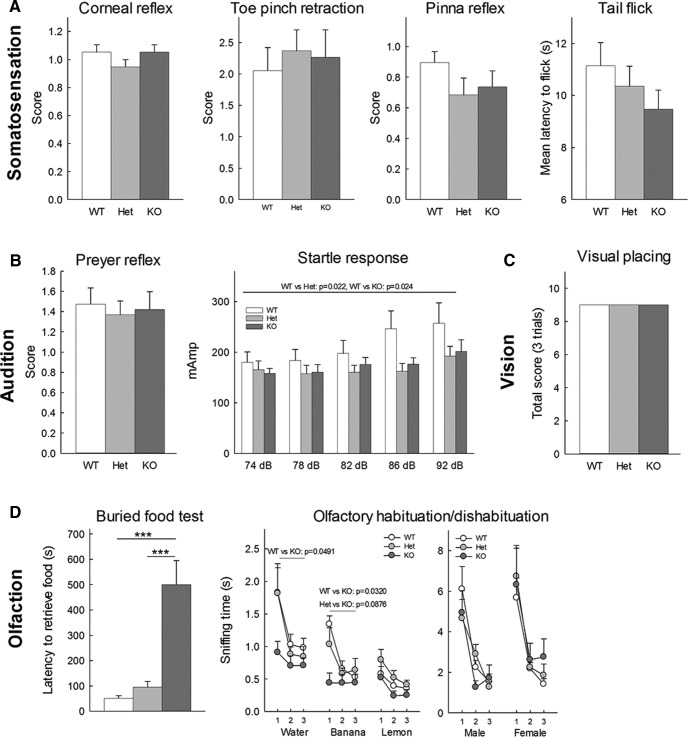
Altered sensory profile in Shank3Δ4-22-deficient mice. A, Somatosensation evaluated with corneal reflex, toe pinch retraction, pinna reflex, and tail flick. Normal tactile and pain responses were observed in Shank3Δ4-22-deficient mice. B, Auditory functions measured with the Preyer reflex and startle response to increasing sound intensities. No genotype difference was observed for Preyer reflex, however startle response was decreased in both heterozygous and homozygous Shank3Δ4-22 mice compared to their wild-type littermate with genotype differences being more marked for the higher startle intensities. Pre-pulse inhibition results are displayed in Extended Data Figure 4-1A. C, Gross visual function assessed by the visual placing test. Normal visual placing was observed for all genotypes. D, Olfactory abilities evaluated by the time to find hidden food in buried food test and the cumulative time sniffing the applicator without direct interactions during olfactory habituation and dishabituation to nonsocial and social odors. Strong impairments were observed in the buried food test for Shank3Δ4-22 homozygous mice as shown by a significant increase in the latency to retrieve the buried food, compared to their heterozygous and wild-type littermates. Individual performances are available in Extended Data Figure 4-1B. Similarly, a significant lack of interest for nonsocial scents (water, banana, and lemon) was observed in Shank3Δ4-22homozygous mice but not in heterozygotes and wild-type during olfactory habituation/dishabituation, while they still displayed normal habituation/dishabituation for social scents (unfamiliar male and female bedding). The olfactory habituation and dishabituation to nonsocial and social odors was measured as cumulative time spent sniffing a sequence of identical and novel odors delivered on cotton swabs inserted into a clean cage. WT, wild-type mice; Het, heterozygous mice; KO, homozygous knock-out mice. *p < 0.05, **p < 0.1, ***p < 0.001.